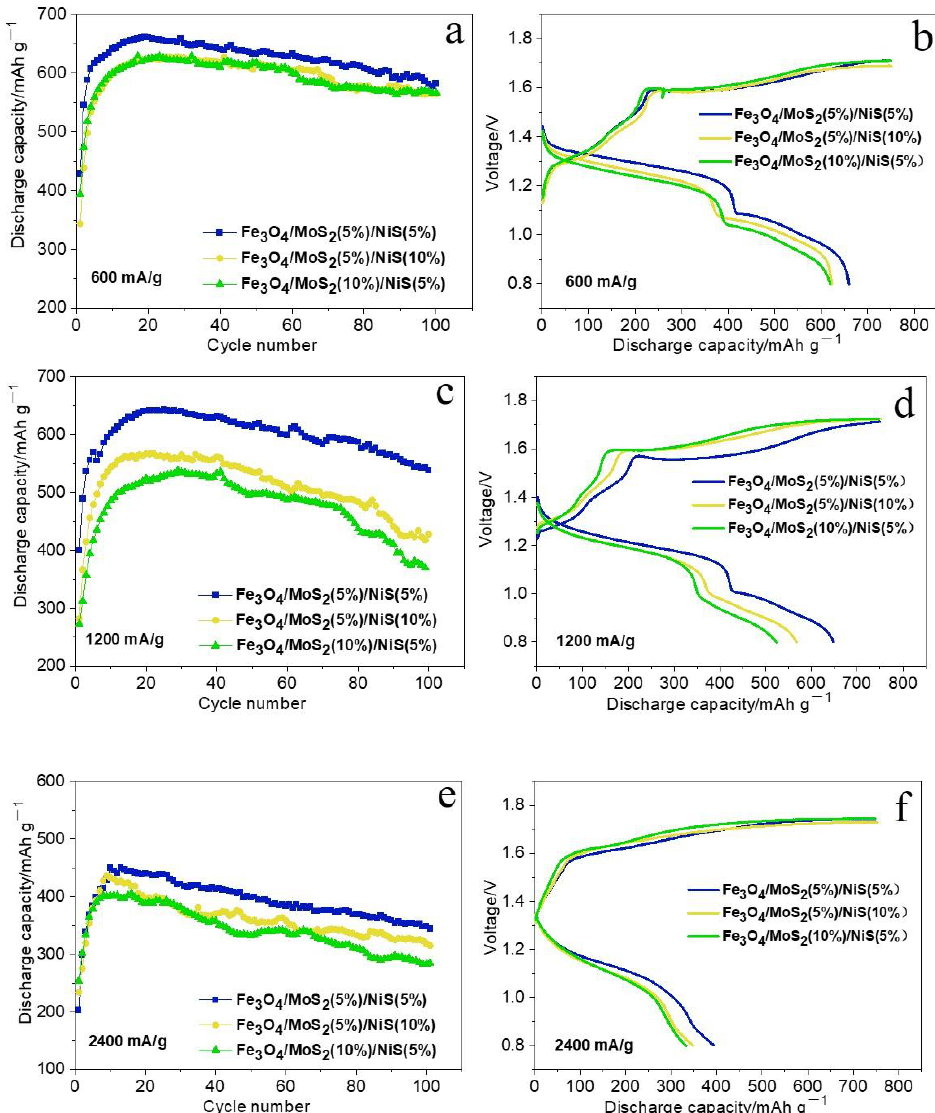
Figure 8. Cycling performance and charging-discharging curves of three electrodes at current den- densities of 600 mA g − 1 ( a , b ), 1200 mA g − 1 ( c , d ), and 2400 mA g − 1 ( e , f sities of 600 mA g −1 ( a , b ), 1200 mA g −1 ( c , d ), and 2400 mA g −1 ( e , f ).